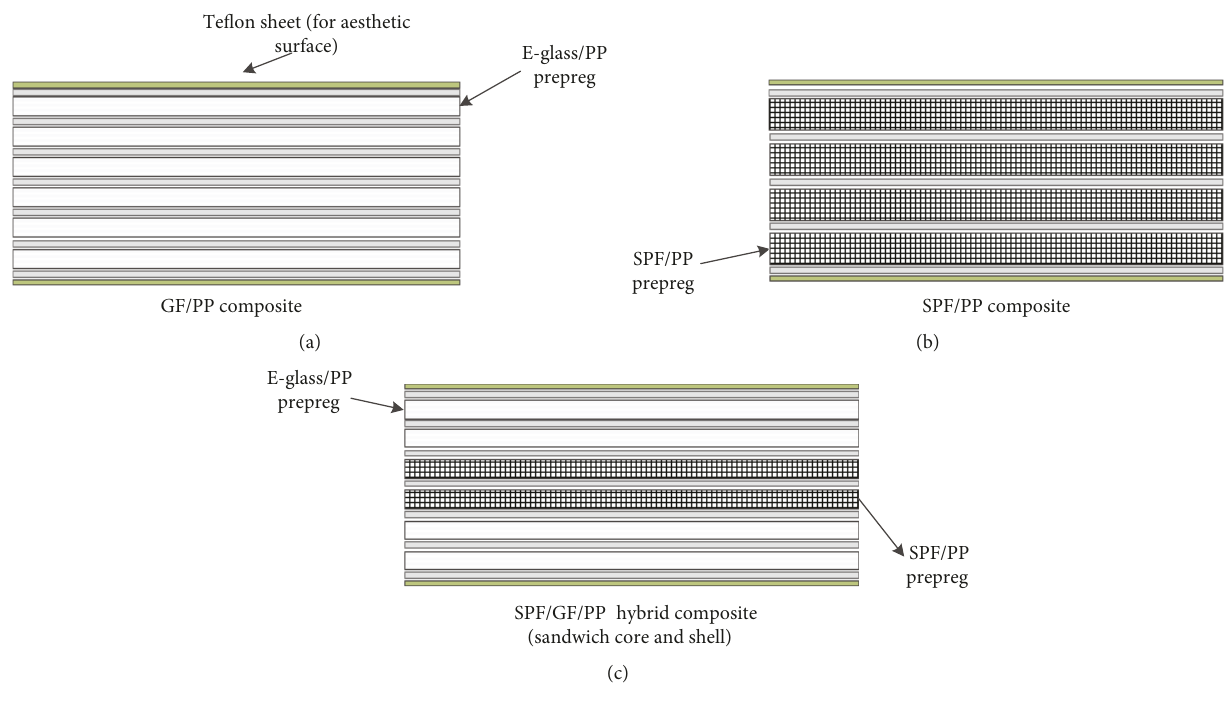
Figure 2: Layers con fi guration of the nonhybrid and hybrid composites.